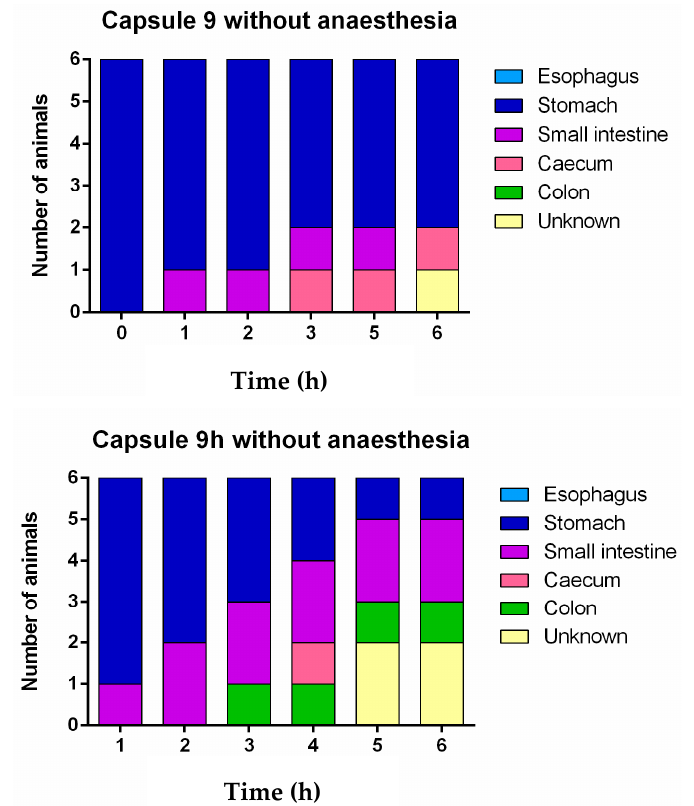
receive anaesthesia.